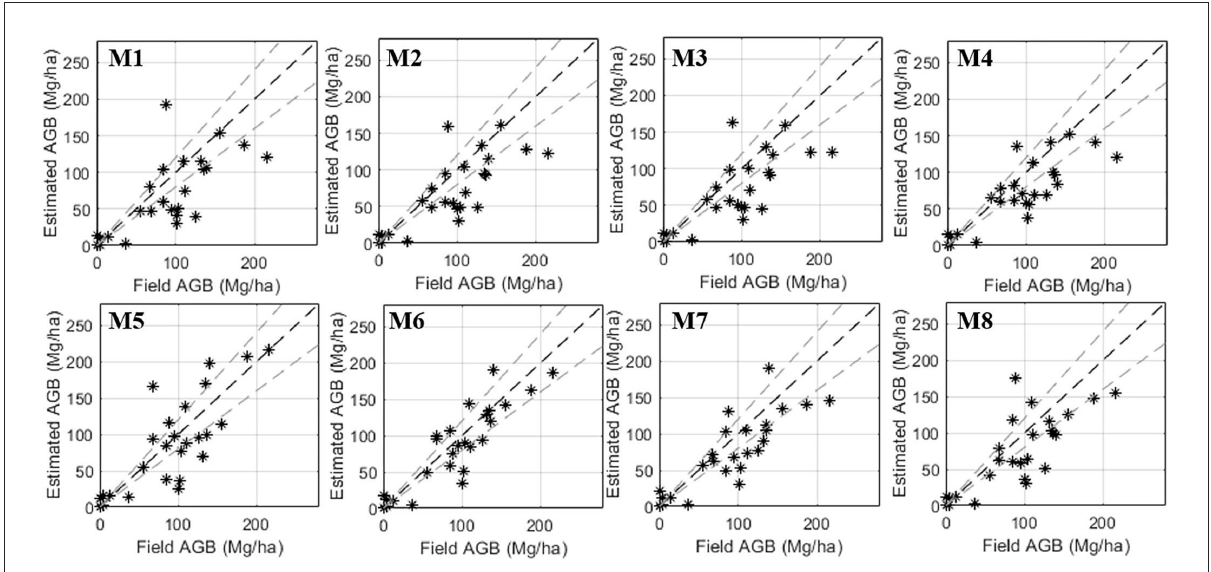
FIGURE8 Comparison of the eight models with training and validation carried out using L-band backscatter from 19-March data and TDX2 height. First row represents models based on backscatter and second row represents combined models based on backscatter and